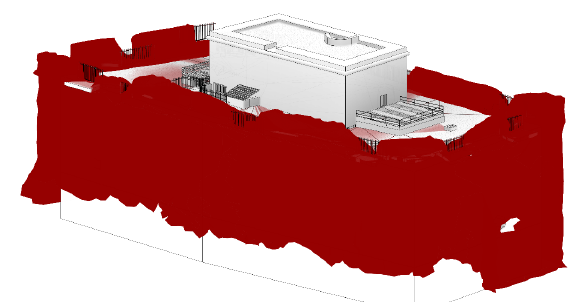
Figure 6. Paphos Castle seaside wall in Revit model elements linked with the Rhinoceros geometry in red